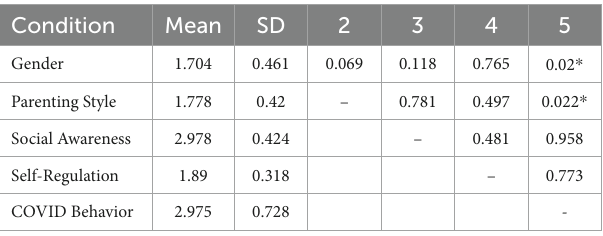
TABLE 1 Descriptive statistics and correlation coefficients for all participants.